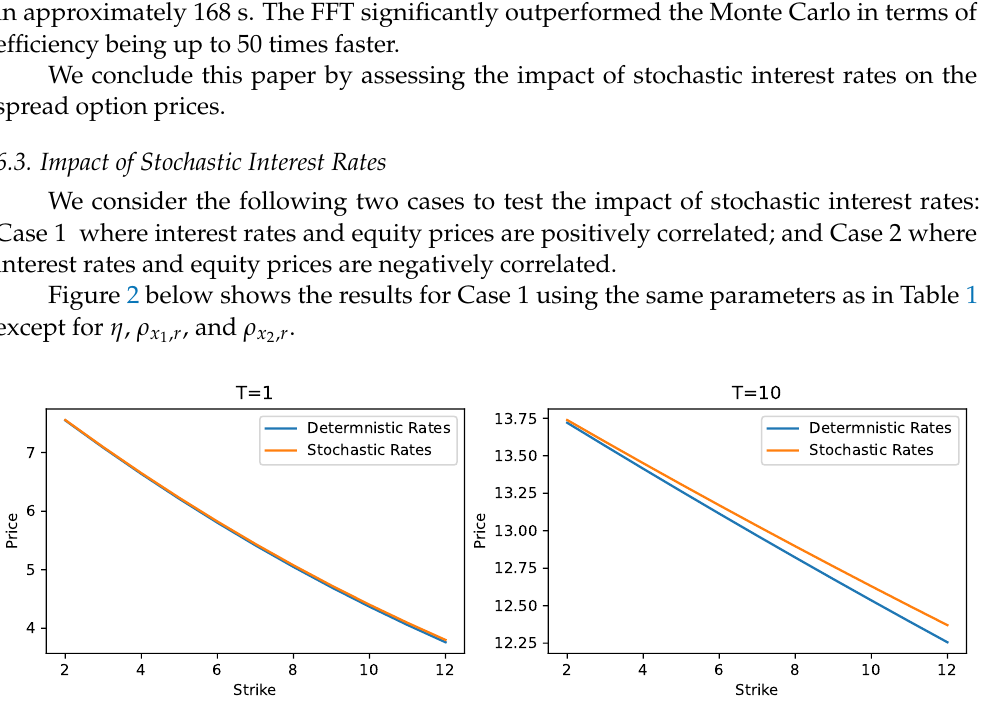
Figure 2. Impact of stochastic interest rates with η = 0.05, ρ x Similarly, Figure 3 below shows the results for Case